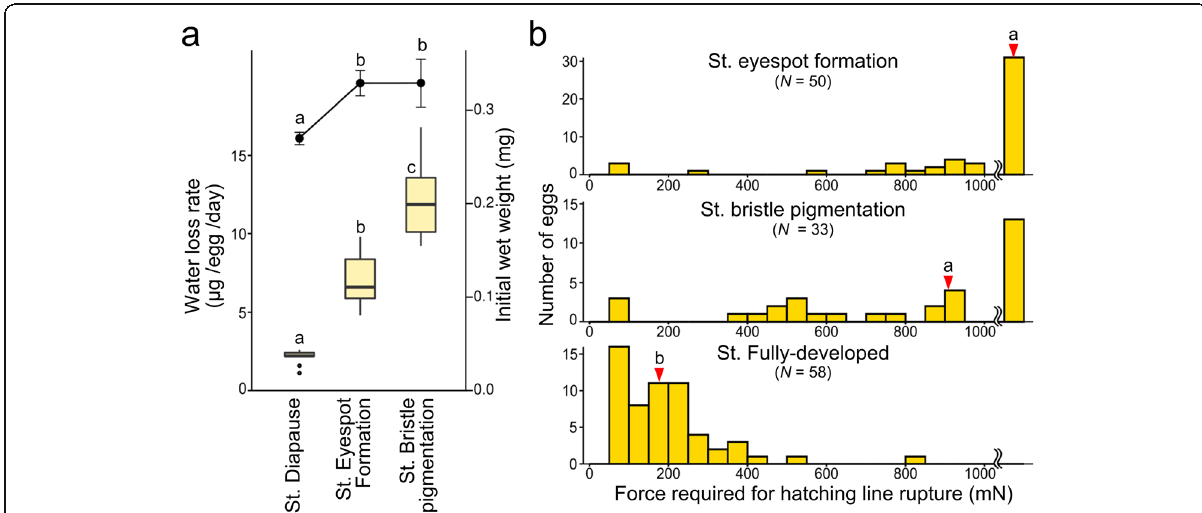
Fig. 7 Dynamic changes in eggshell properties with serosal cuticle degradation. a Change in water-loss rates. Box plots indicate water-loss rates after 5 days of exposure to 43% relative humidity conditions; these rates were assessed gravimetrically in eggs at various developmental stages. The initial weights at each developmental stage are also shown by line plots. Different letters indicate statistically significant differences ( N = 12 samples (each containing 10 eggs), likelihood ratio test of a generalized linear model, P < 0.05). b Change in hatching-line cleavability. The pushing force needed to cause a rupture of the hatching line was measured. The number of eggs that were not ruptured by less than 1000 mN and the number that burst in locations other than the hatching line are shown in the rightmost bars. Median values for each developmental stage are indicated by red triangles, and different letters indicate significant differences (Steel-Dwass test, P <